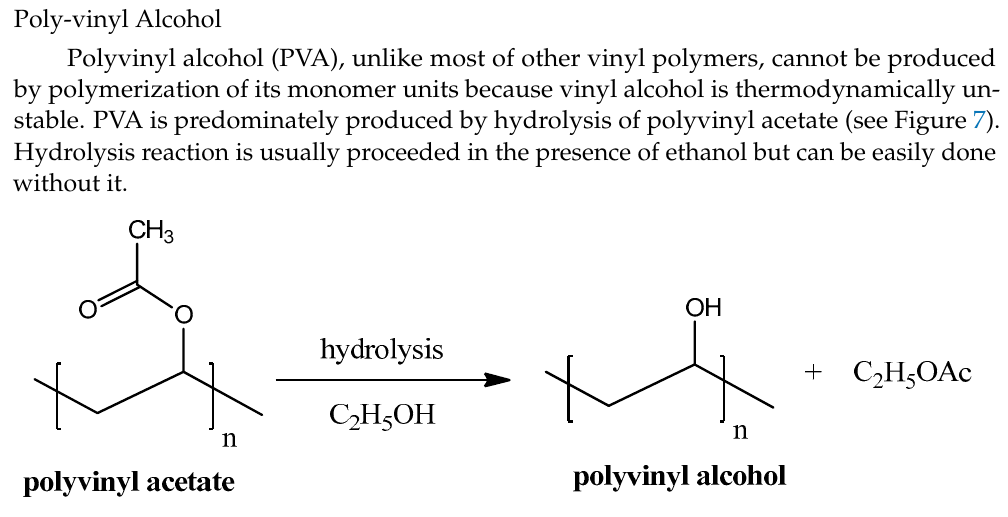
Figure 6. Synthesis routes of some petrochemical derived biodegradable plastics. ( A ) Poly- ε -capro- lactone; ( B ) Poly-propylene Fumarate; and ( C ) Poly-ethylene Glycol.